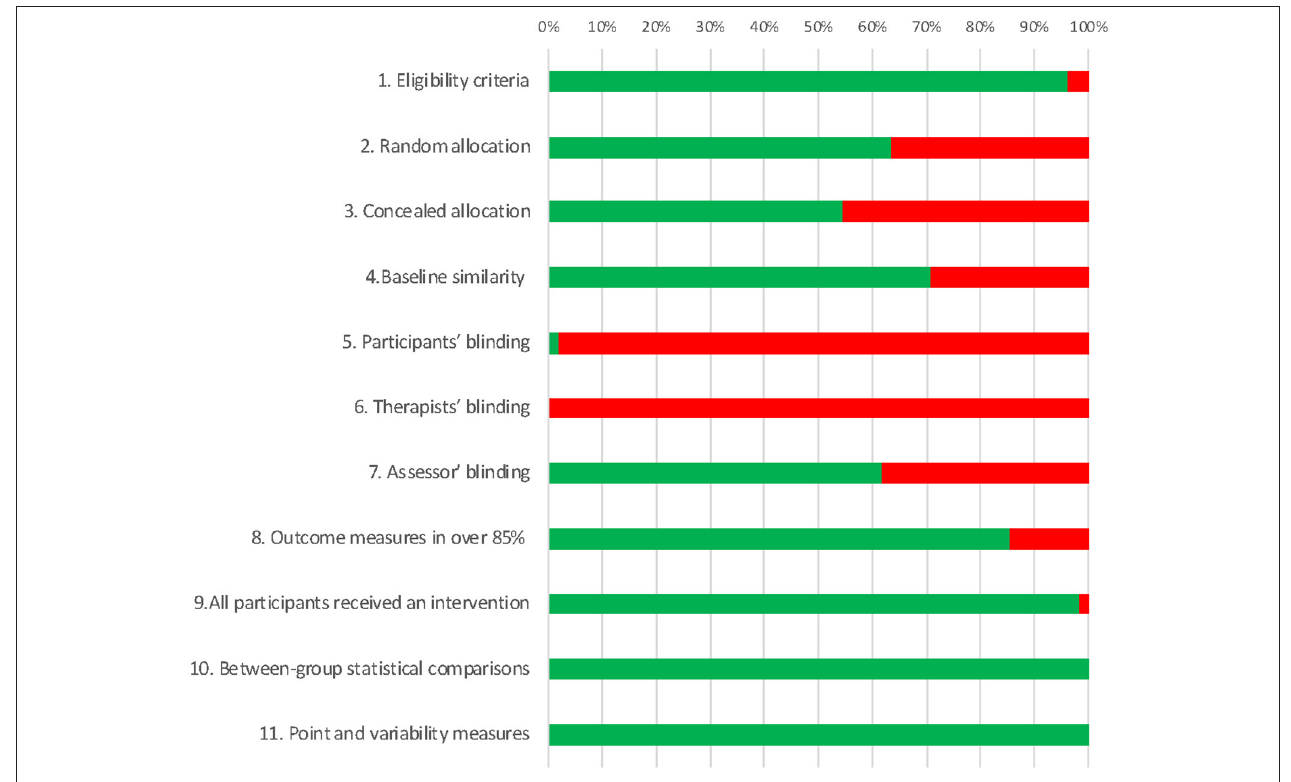
FIGURE 3 | Risk of bias assessment: percentage of included articles fulfilling each of the PEDro scale items.